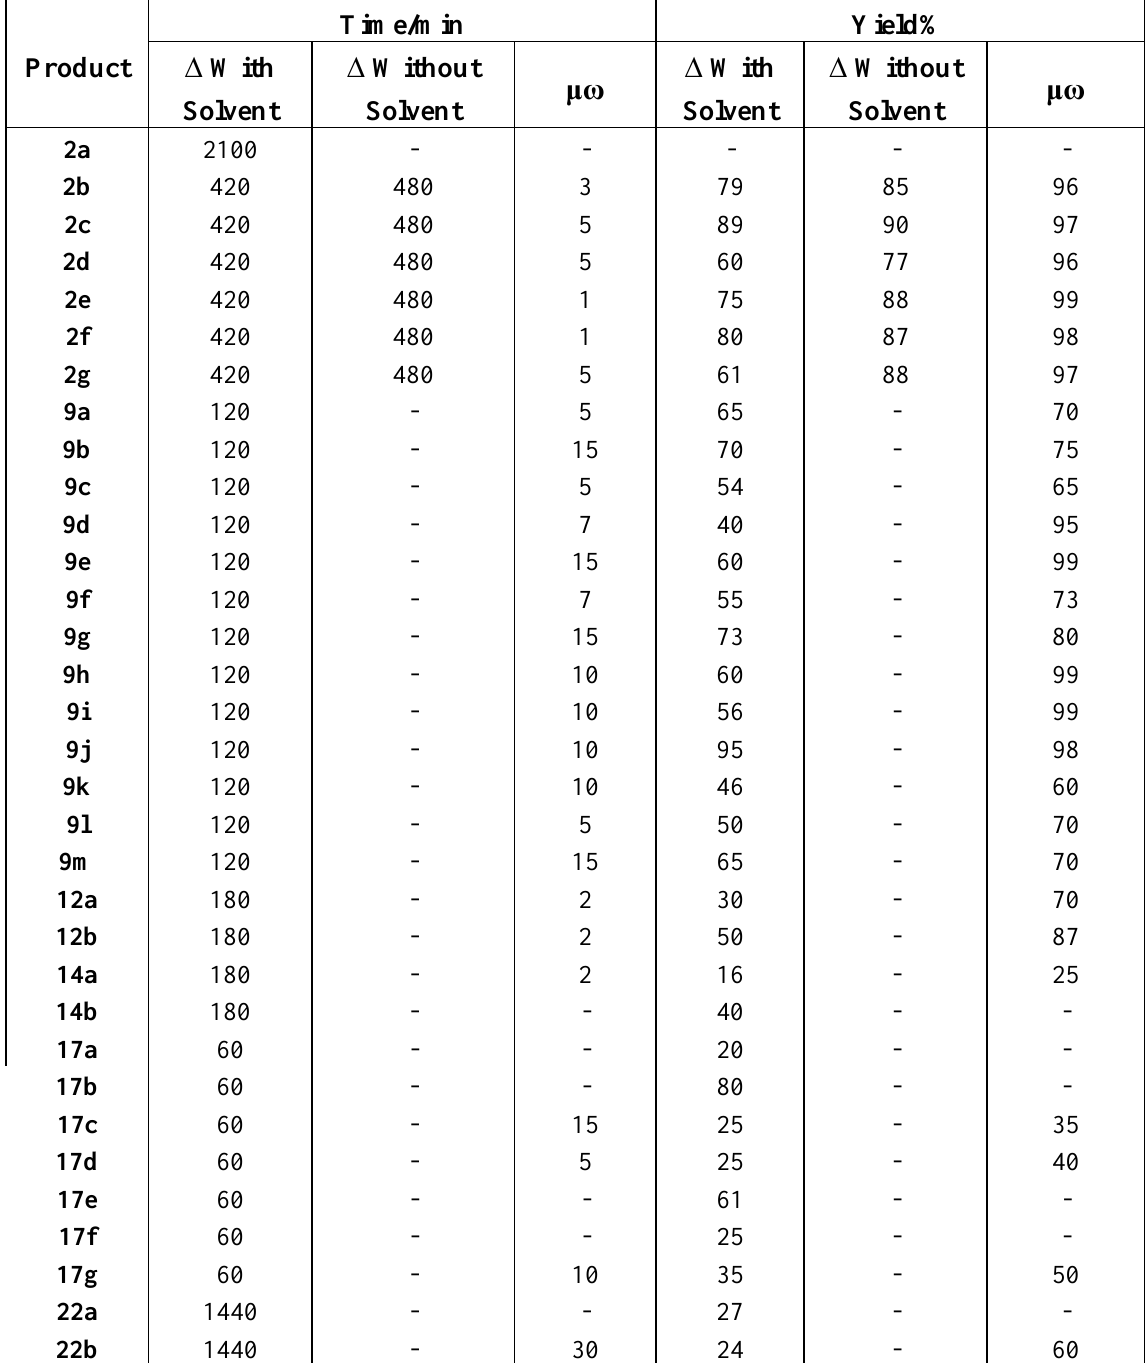
Table 2. Comparison between microwave and conventional heating